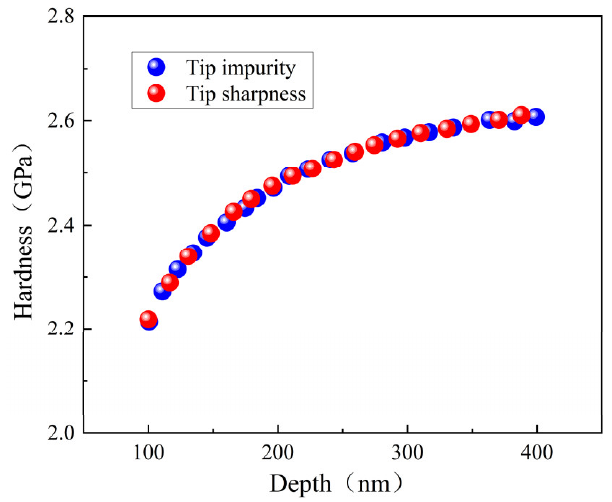
Figure 16. Comparison of hardness–depth dependence of tip impurity and tip sharpness.